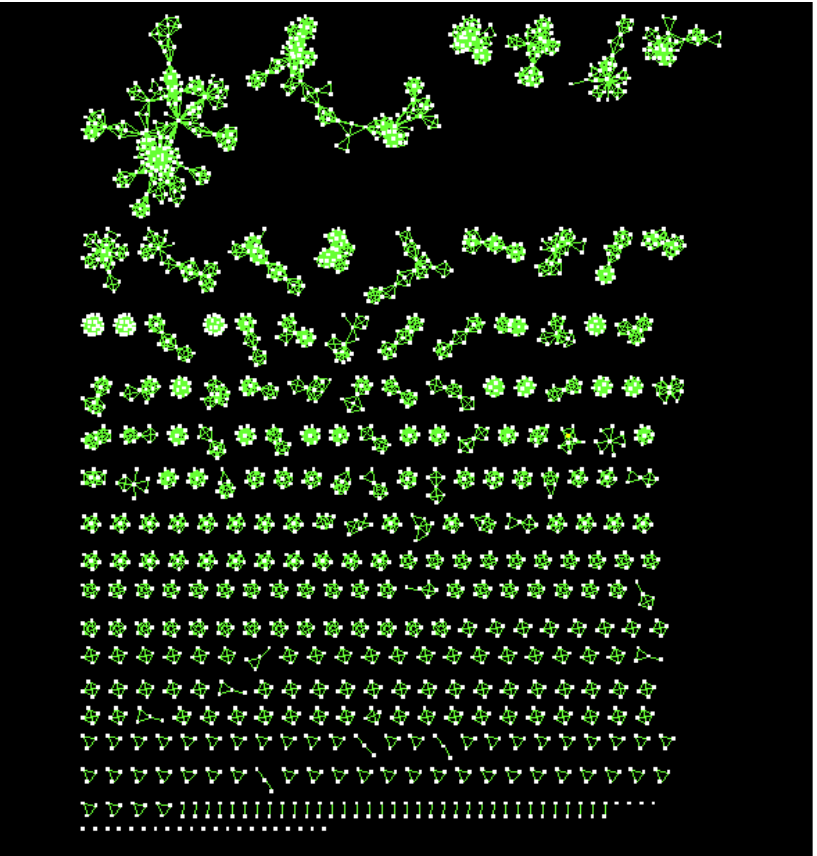
Figure 8. Graphical visualization of the Co-A. Visual representation of the co-authorships, in which the Authors are represented as nodes and the co-authorships as links. This schematic image shows how the scientific community is highly fragmented, with few groups collaborating and multiple small, isolated groups.